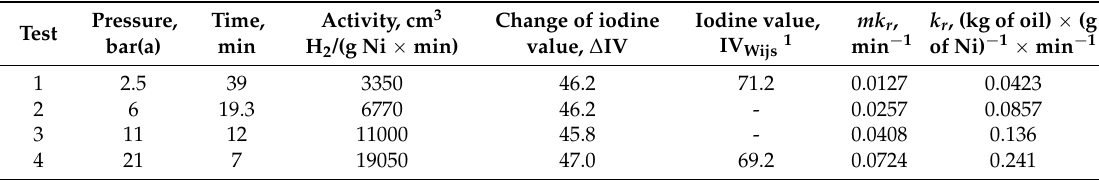
Table 2. Hydrogenation of canola oil on INS Ni_C catalyst.